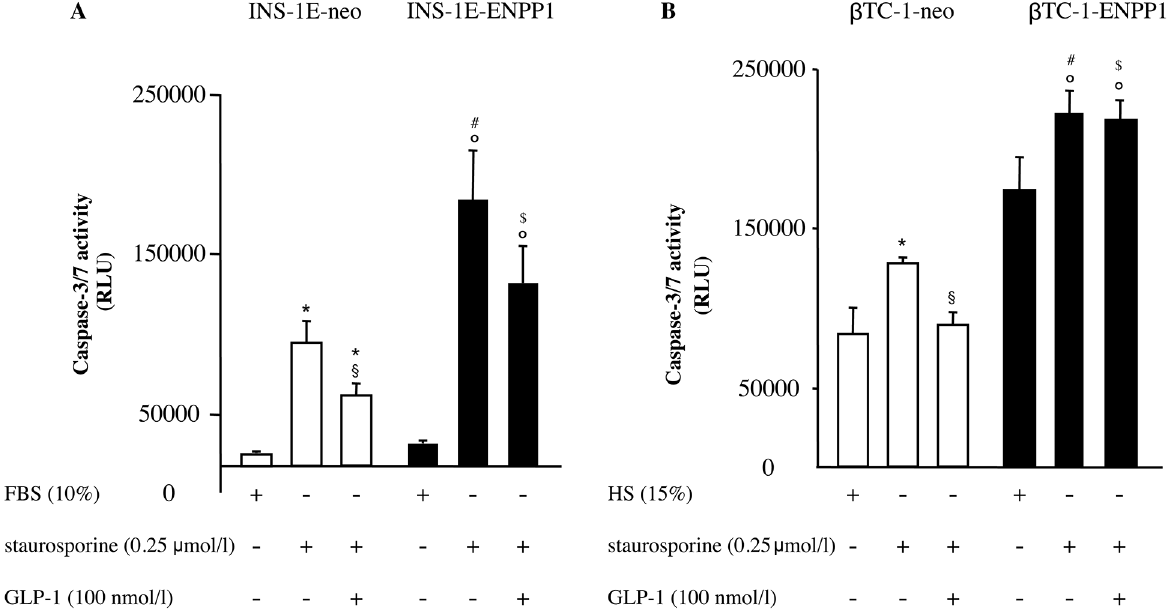
Fig 3. GLP-1 fails to rescue apoptosis in ENPP1 transfected cells. Apoptosis was assessedby caspase 3/7 activity, in INS-1E (panelA) and β TC-1 (panelB) cells, either transfected with neo or ENPP-1 genevariant. Cells were treated with staurosporine (0.25 μ mol/l, 2 hours) in the absenceor presenceof 100 nmol/l GLP-1. Treatment with GLP-1 significantly decreased apoptosisinduced by staurosporine in INS-1E-neoand in β TC-1-neo cells but not in INS-1E-ENPP1 and in β TC-1-ENPP1 cells. Valuesare